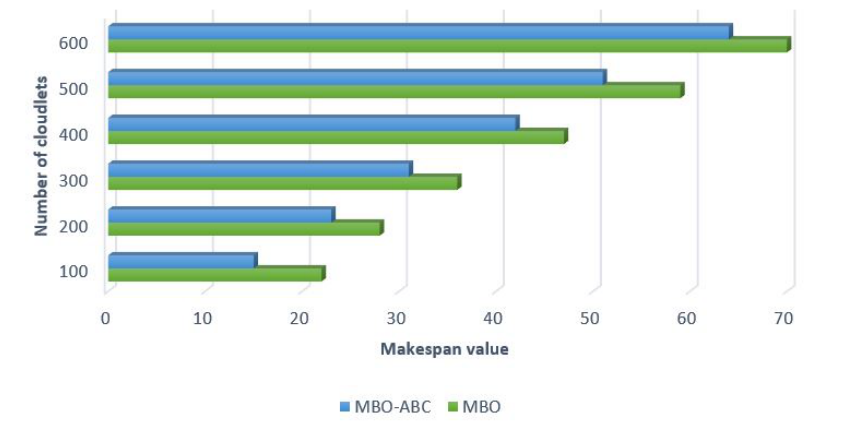
Figure 10. Comparative analysis—MBO-ABC vs. MBO at arrival rate of 10 cloudlets per second with artificial data